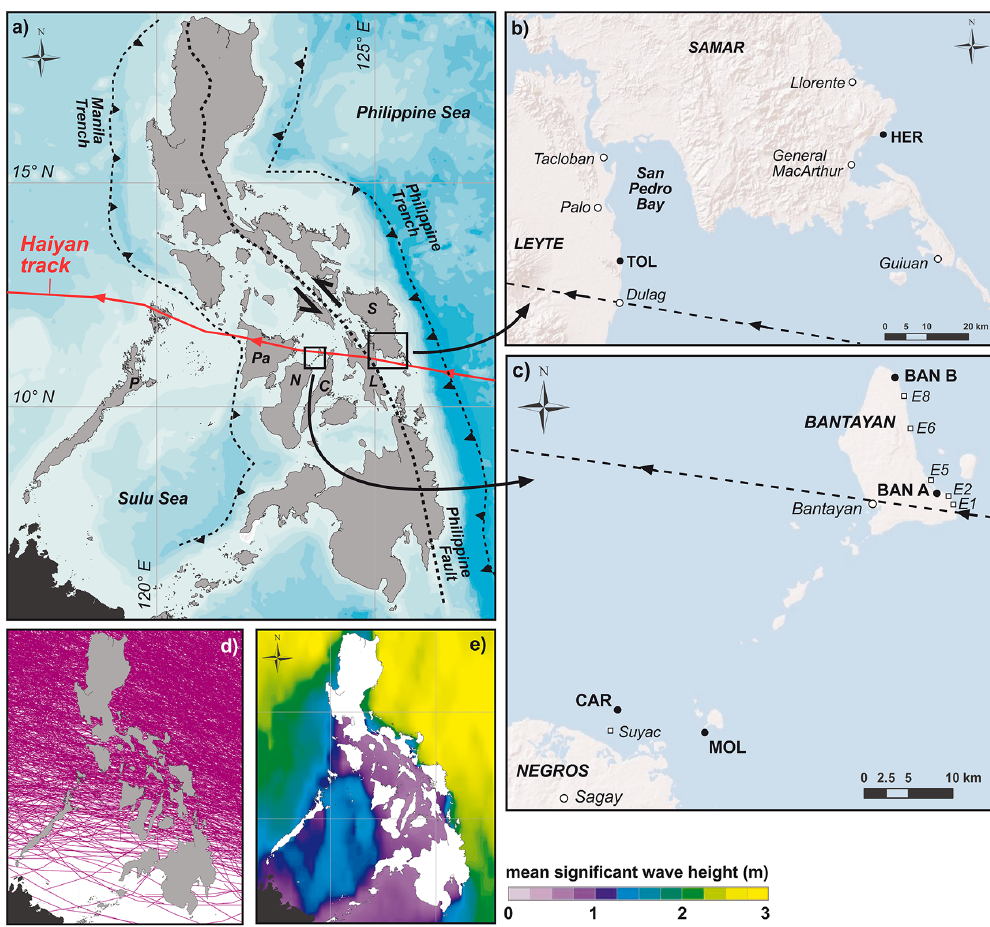
Figure 1. Overview of the study area. (a) Philippine archipelago with main tectonic structures (Rangin et al., 1989) and track of Typhoon Haiyan (NDRRMC 2014); (b) position of research areas on Samar and Leyte as well as (c) northern Negros and Bantayan (based on ESRI base maps). S: Samar; L: Leyte; C: Cebu; N: Negros; Pa: Panay; P: Palawan. (d) Historical cyclone tracks crossing the Philippines since the beginning of weather recording (NOAA Historical Hurricane Track Pool) illustrate a decreasing cyclone frequency from north to south. (e) Mean significant wave heights (Navy METOC, 2014) indicate highest wave energy during winter monsoon along the exposed east coasts and usually calm conditions in the interior parts of the